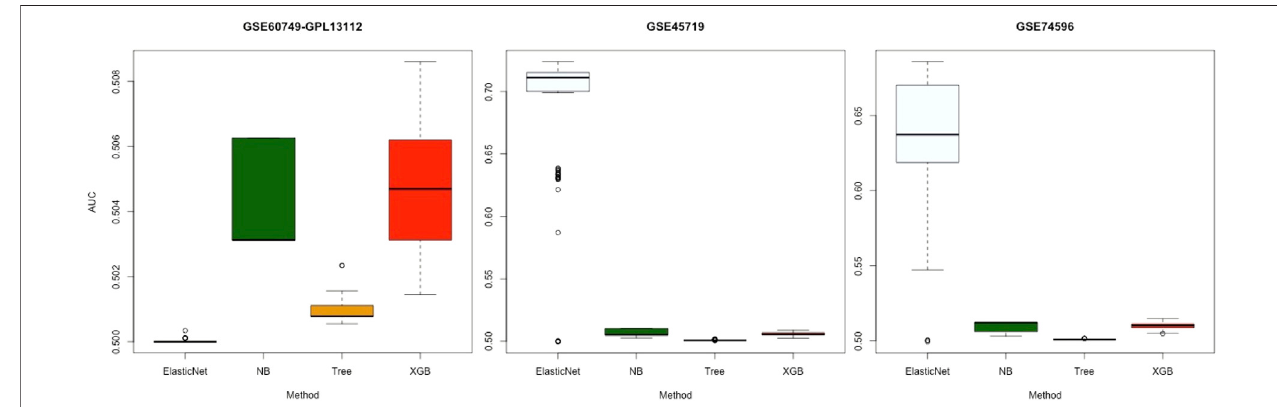
FIGURE 4 | Gene-selection results from the four algorithms on 100 subsets of each simulated dataset. There are three datasets from left to right, and we have marked the dataset names at the top. Each box shows the AUC values of the four algorithms after 100 runs of gene selection on each simulated dataset. The horizontal axes are arranged by algorithm